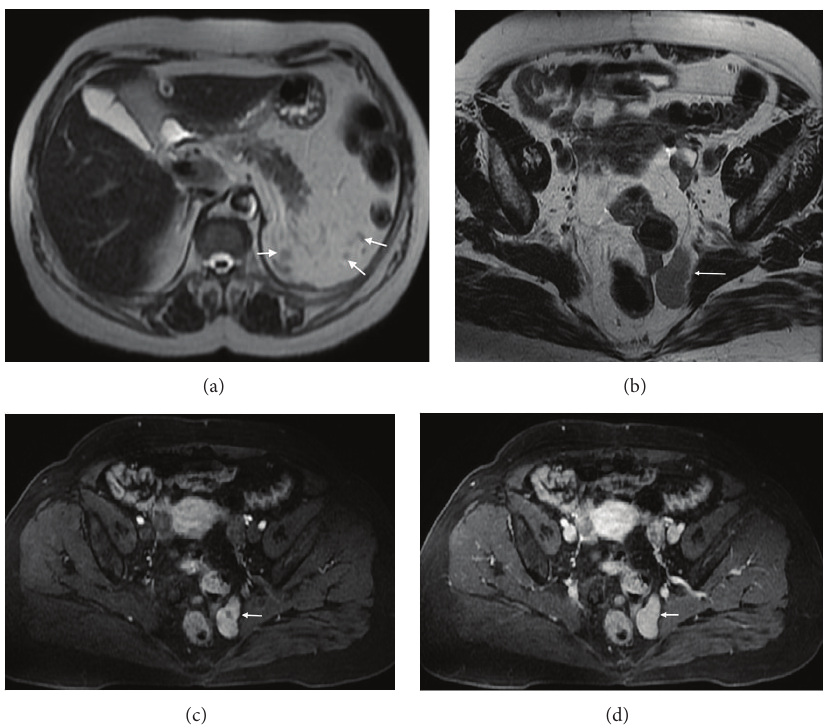
Figure 4: Pelvic splenosis. Axial (a) T2wi SSFSE, axial (b) T2 wi FSE and postcontrast axial T1wi 3D-GRE with fat suppression in the arterial (c) and venous (d) phase. This patient with history of splenectomy following a car accident underwent pelvic MRI to clarify pelvic masses depicted in previous CT. There are multiple nodular masses in the left hypochondrium (arrows, (a)) consistent with splenosis. There are also multiple well-defined nodules in the pelvis demonstrating high signal intensity on T2wi (arrow, (b)), with heterogeneous enhancement immediately after contrast material administration (c), becoming homogeneous in the venous (d) phase, consistent with splenosis.